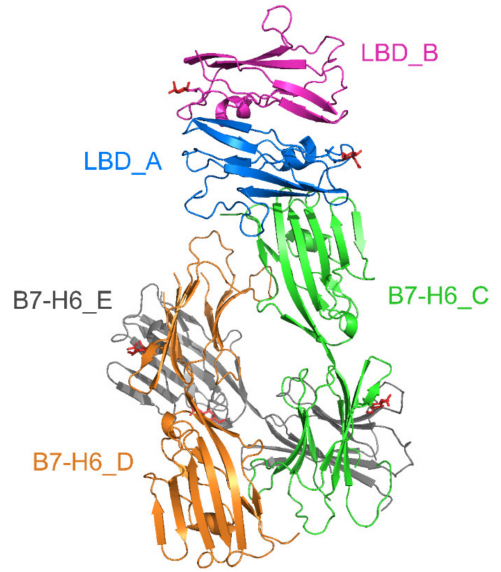
Figure 8. Crystal structure of uniformly glycosylated NKp30_LBD in complex with deglycosylated B7-H6. The asymmetric unit contains two molecules of NKp30_LBD (chains LBD_A and B) and three molecules of B7-H6 (chains B7-H6_C, D and E). Interaction interface between chains LBD_A and B7-H6_C corresponds to the interaction surface observed in the previously published structure of this complex (PDB 3PV6)